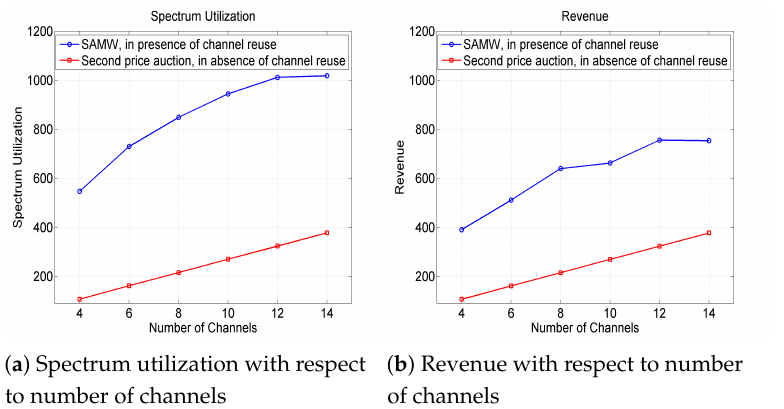
Figure 11. Spectrum utilization and revenue for SAMW and second-price auction with respect to number of channels.